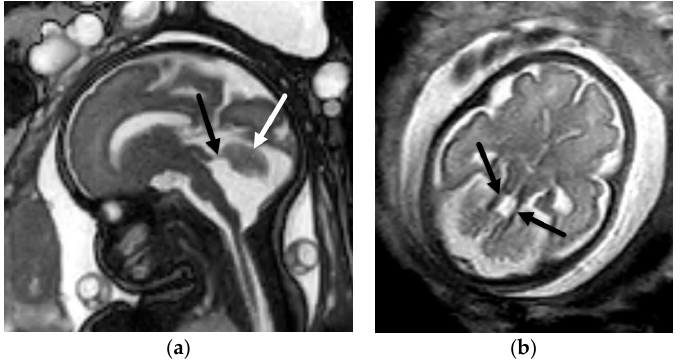
Figure 10. Joubert syndrome. Sagittal BTFE/FIESTA image ( a ) in a 29-week, 6-day GA fetus demon- strates vermian hypoplasia (white arrow) with horizontal orientation of the superior cerebellar peduncles (black arrow). Axial T2-SSFSE image ( b ) in the same fetus confirms the “molar tooth” sign with thickened and horizontal orientation of the superior cerebellar peduncles (arrows). Postnatal genetic testing confirmed Joubert syndrome in this patient.